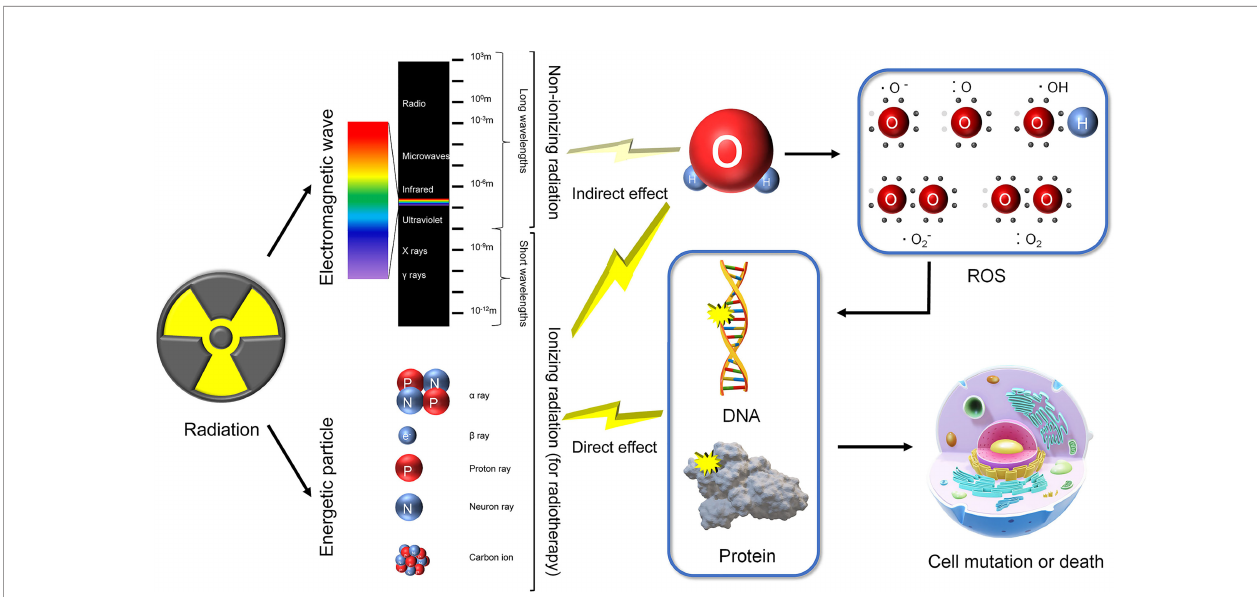
FIGURE 1 | Classi fi cation of radiation and mechanisms of radiation-induced injury. Radiation comprises of energetic particles and electromagnetic waves. Energetic particles and short wavelength electromagnetic waves (X rays and g rays) are classi fi ed as ionizing radiation. Longer wavelength electromagnetic waves (>100 nm) are categorized as nonionizing radiation. Ionizing radiation has enough energy to directly break DNA and protein. In addition, ionizing radiation can produce ROS (mainly by ionizing H 2 O), indirectly inducing DNA and protein damage. Nonionizing radiation may also produce little ROS. Impaired DNA and protein fi nally lead to cell mutation or